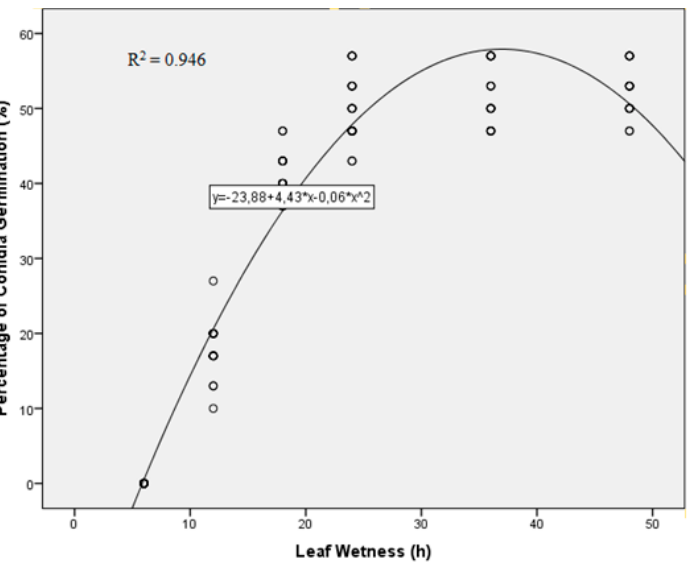
Figure 2. Effect of leaf wetness on the conidia germination of Venturia oleaginea. The parameters of minimum and maximum leaf wetness were fit to the generic model.